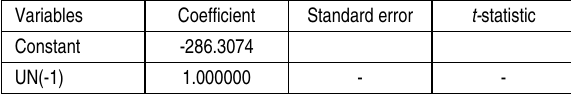
Table 5. Long-run cointegration equation